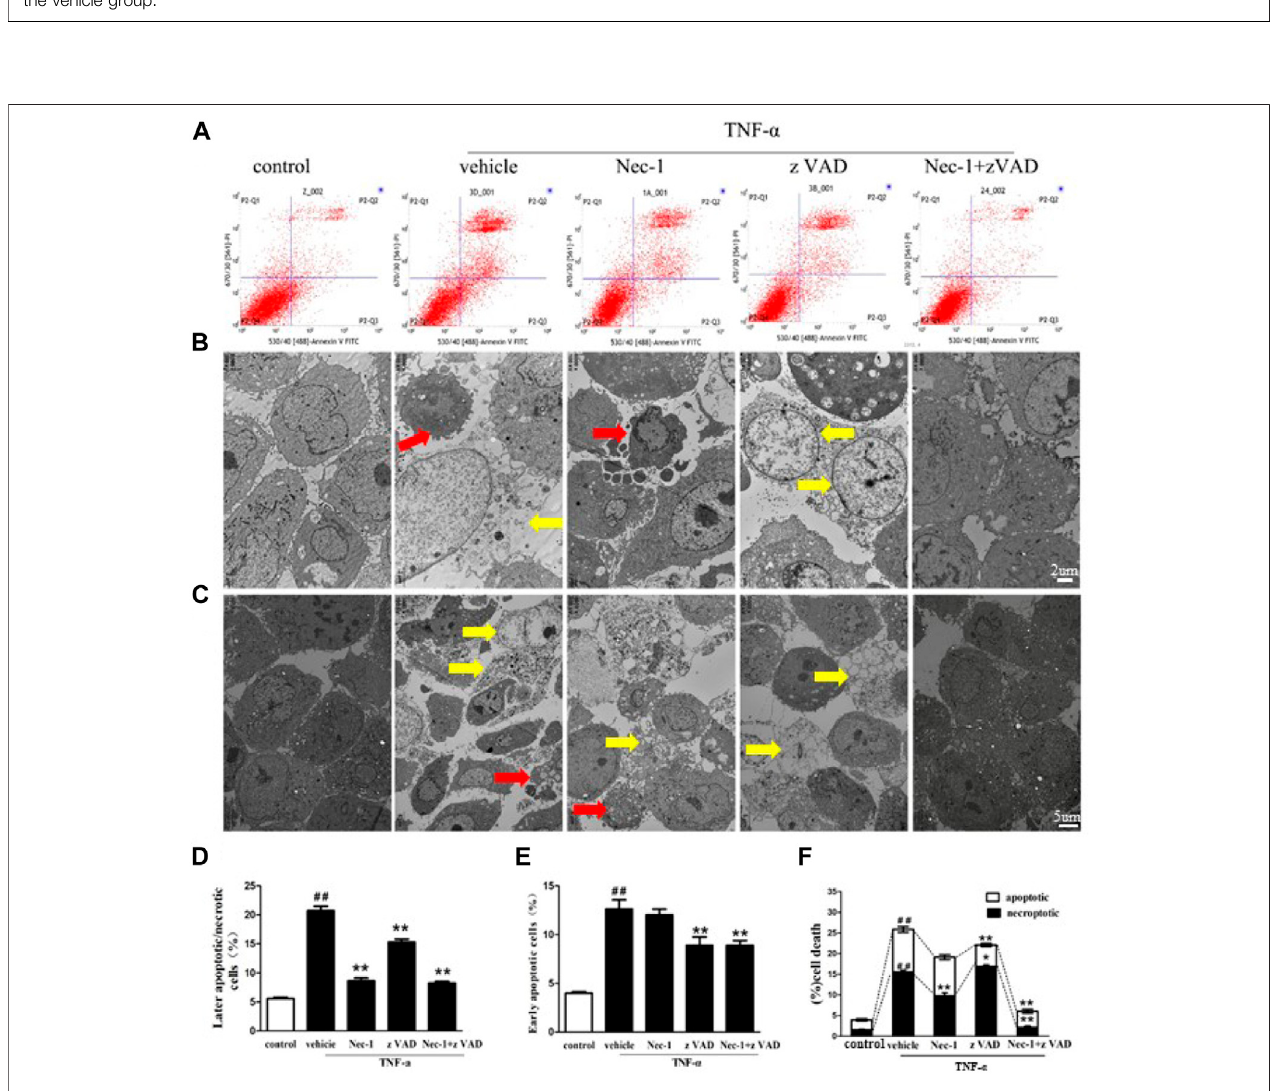
FIGURE6 | TNF- α – induced necroptosis and apoptosis ofMLO-Y4cells. (A, D, E) Necrotic and apoptotic osteocytes were tested using the fl ow cytometer. MLO- Y4 cells were pretreated for 30 min with DMSO (1%), Nec-1 (30 mmol/L), zVAD (25 mmol/L), or Nec-1 (30 mmol/L) + zVAD (25 mmol/L) and then treated with TNF- α (100 ng/ml) for 24 h in vitro . Then, MLO-Y4 (upper panel) cells were stained with FITC Annexin V and PI to determine necrotic and apoptotic osteocytes by fl ow cytometry. (B, C, F) TEM images of osteocytes pretreated for 30 min with DMSO (1%), Nec-1 (30 mmol/L), zVAD (25 mmol/L), or Nec-1 (30 mmol/L) + zVAD (25 mmol/L) and then treated with TNF- α (100 ng/ml) for 24 h in vitro (B: scale bar (cid:1) 2µm, C: scale bar (cid:1) 5 µm). Red arrow: apoptotic cells, yellow arrow: necroptotic cells. ## p < 0.01 compared with the control group, * p < 0.05 compared with the vehicle group, ** p < 0.01 compared with the vehicle group.